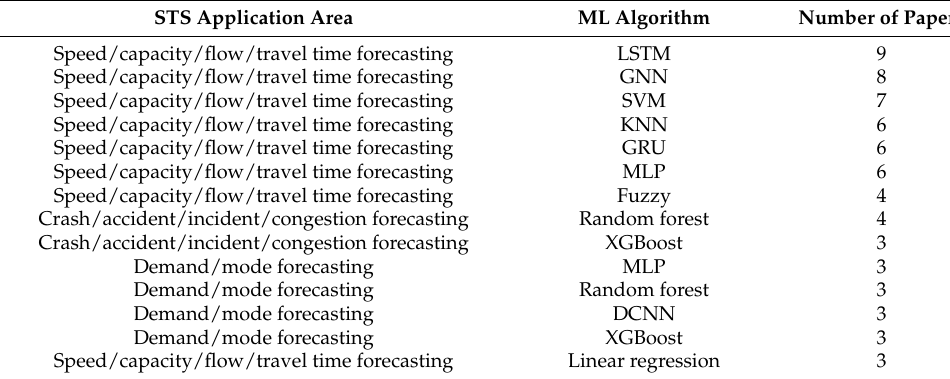
Table 5. Most utilized ML algorithms in STS application